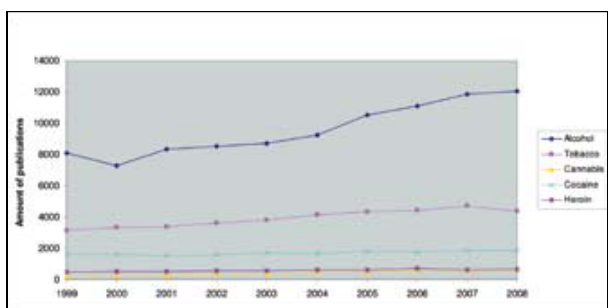
Fig. 2. Comparison of numbers of publications on alcohol, tobacco, cannabis, cocaine and heroin, 1999 - 2008.